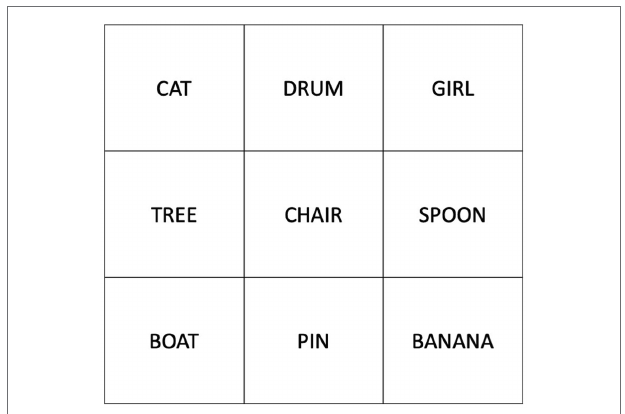
FIGURE 1 | Stimulus arrangement in the Spatial Learning Task of Lhermitte and Signoret (1972). Photographs were used in the original study, with simple line drawings used in a number of subsequent studies (see Anderson and Lajoie, 1996 for an example) including the present